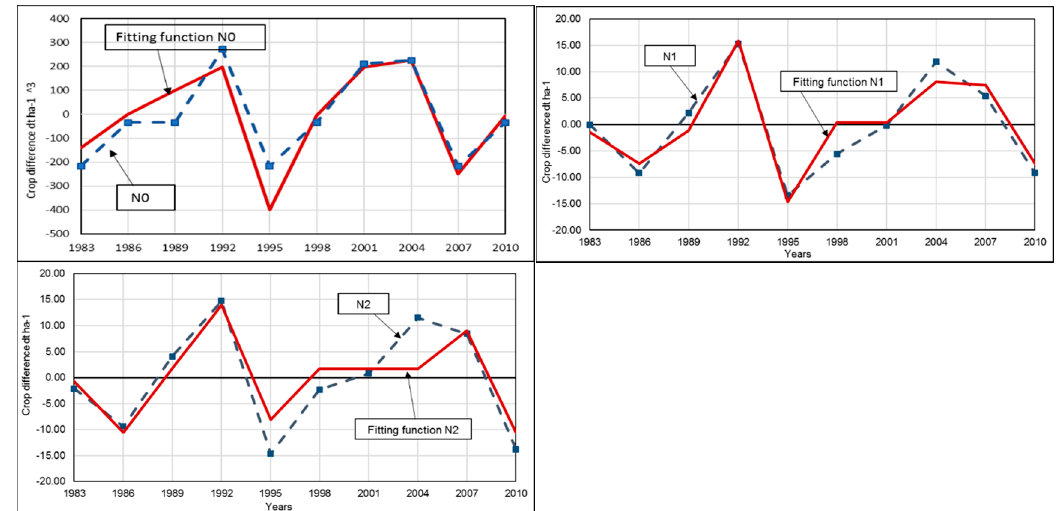
Figure 3. Measured and predicted (see Table 3) residuals with monthly predictors for the different fertilization levels (N0 unfertilized plots, low fertilized plots N1, high fertilized plots N2, N0 expressed as transformed variable).